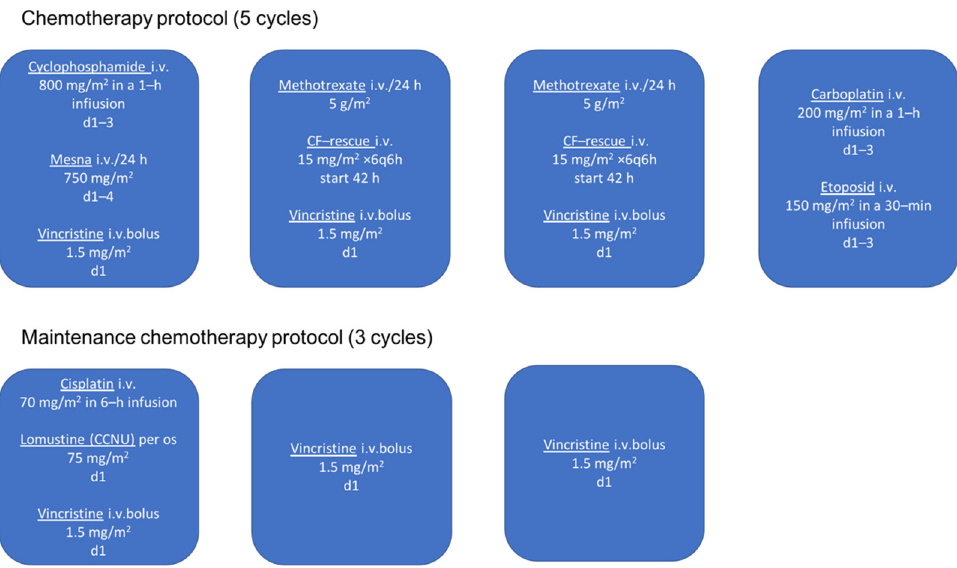
Figure 1. Chemotherapy protocol in patient treated for anaplastic ependymoma (HIT 2000).